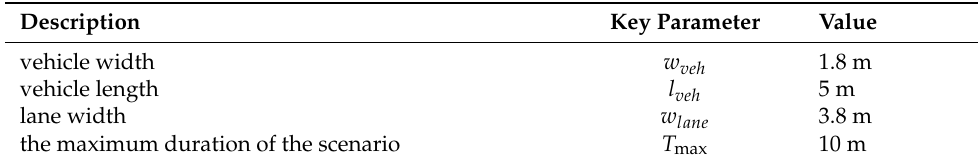
Table 4. Other parameters for the car-following scenario and the cut-in